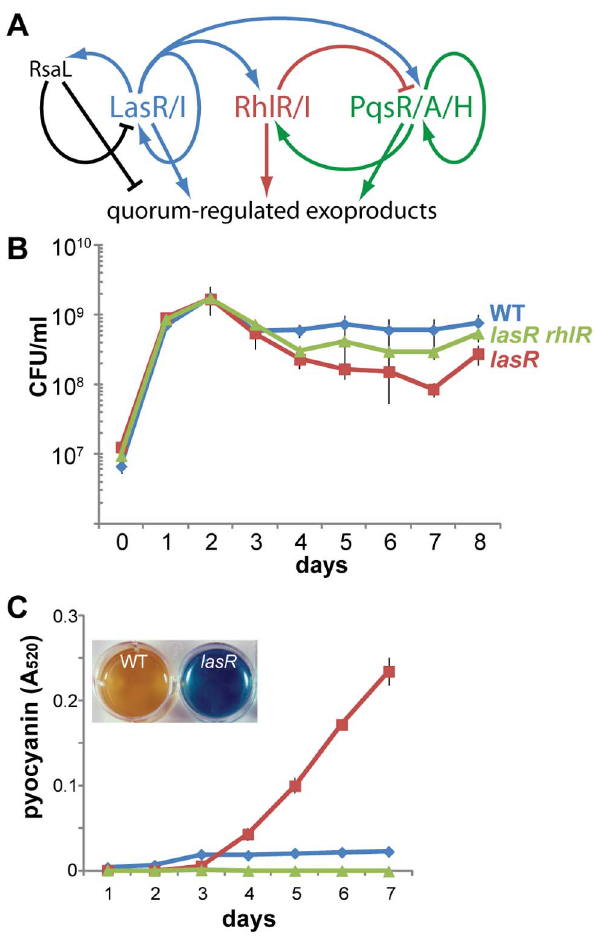
Figure 1. A lasR mutant overproduces pyocyanin under stationary-phase culture conditions. A. A simplified diagram showing some of the regulatory pathways linking the three quorum- sensing systems of P. aeruginosa and exoproduct synthesis. Each system and its regulatory pathways is color coded. B. Plot of the number of live cells (colony-forming units) in static cultures of strains with wild-type (WT) PA14 (MTC772), PA14 lasR (MTC774), and PA14 lasR rhlR (MTC797) backgrounds in LB at 25 u C. C. Pyocyanin quantification in static cultures of wild-type (WT) PA14 (MTC1), PA14 lasR (MTC390), and PA14 lasR rhlR (MTC626) in LB at 25 u C. The inset image shows the appearance of the cultures in a 12-well plate after 7 d. All plots show the mean 6 standard deviation of 3 biological